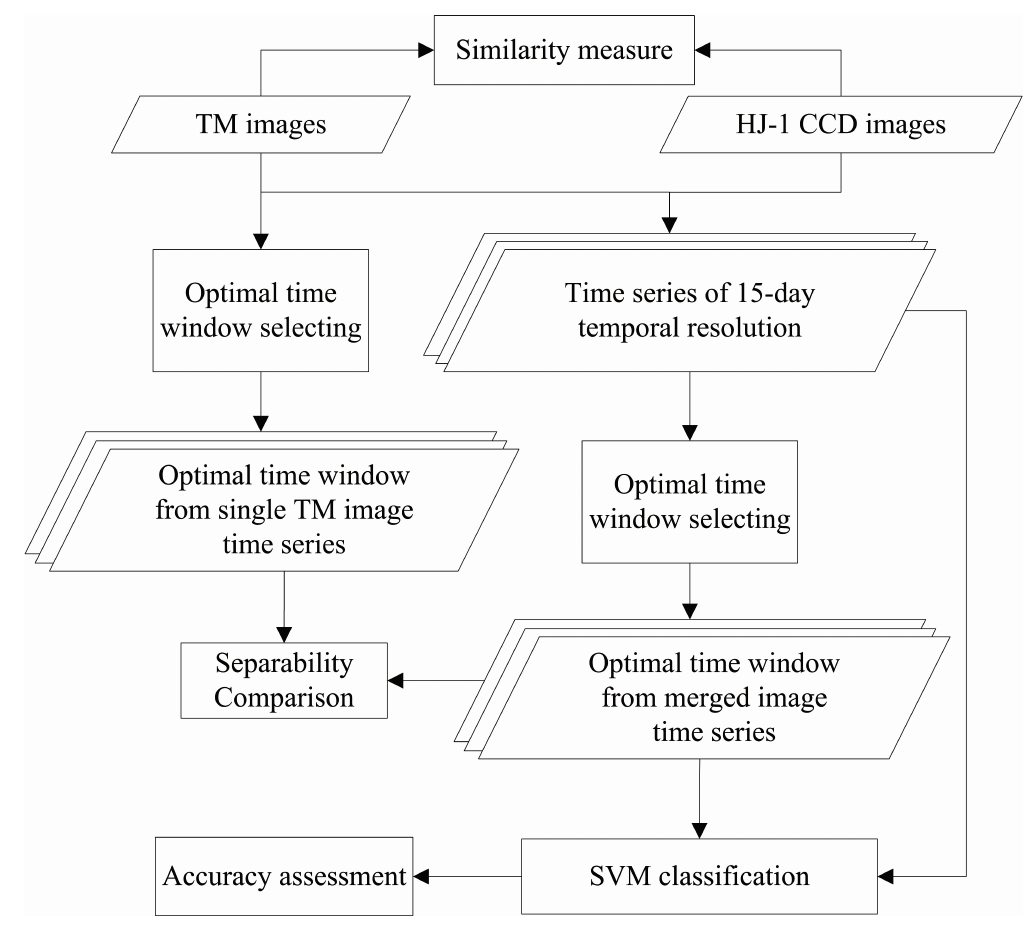
Figure 3. Methodology used in this